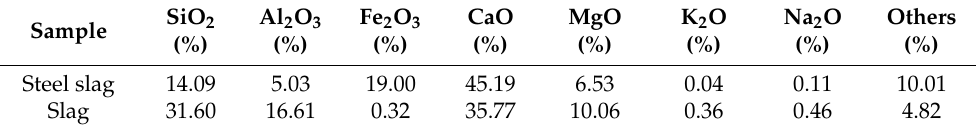
Table 1. Composition of